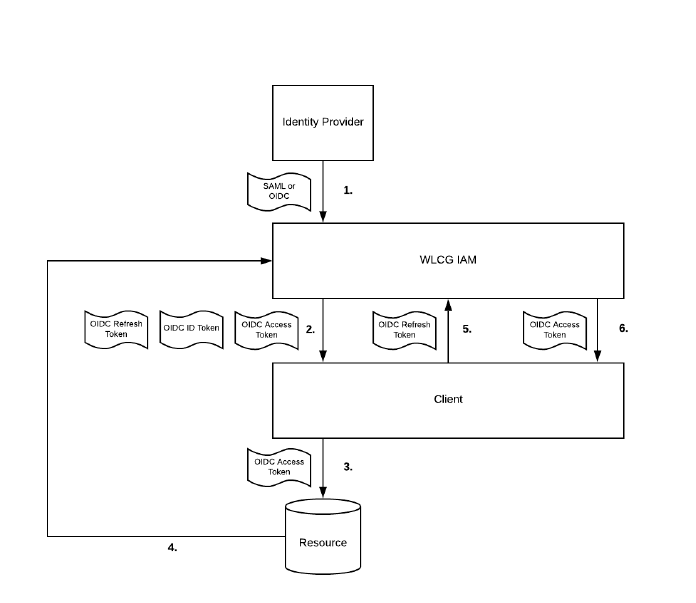
Figure 3. Anticipated token flow, starting from a SAML or OIDC token being issued from the Iden- tity provider to WLCG IAM. WLCG IAM then issues multiple OIDC tokens to downstream clients, granting access to protected